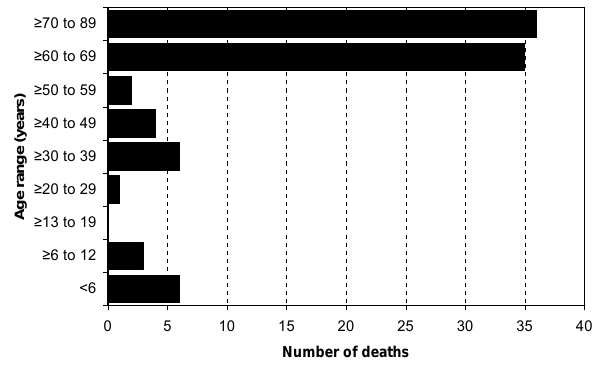
Fig. 6. A typical wooden house that was swept away in the 1953 flood. (Sources: Pollard, 1978 and Baxter, 2005).